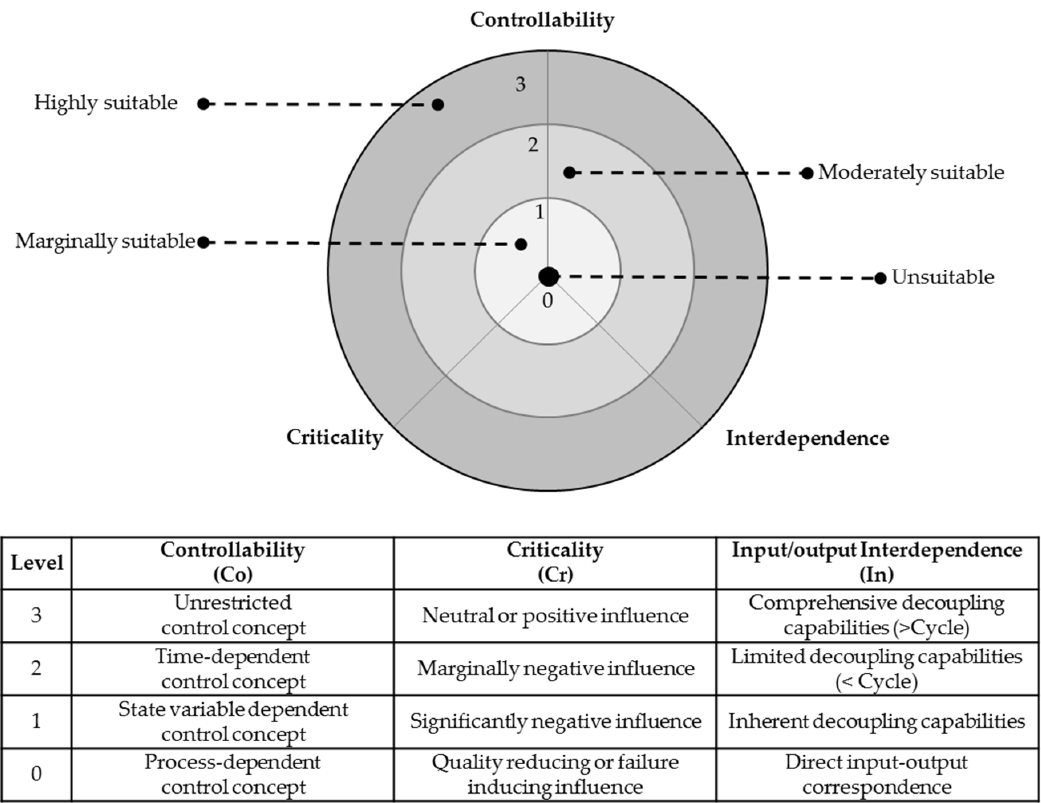
Figure 5. Radar chart to assess the suitability of industrial systems for energy flexible operation.